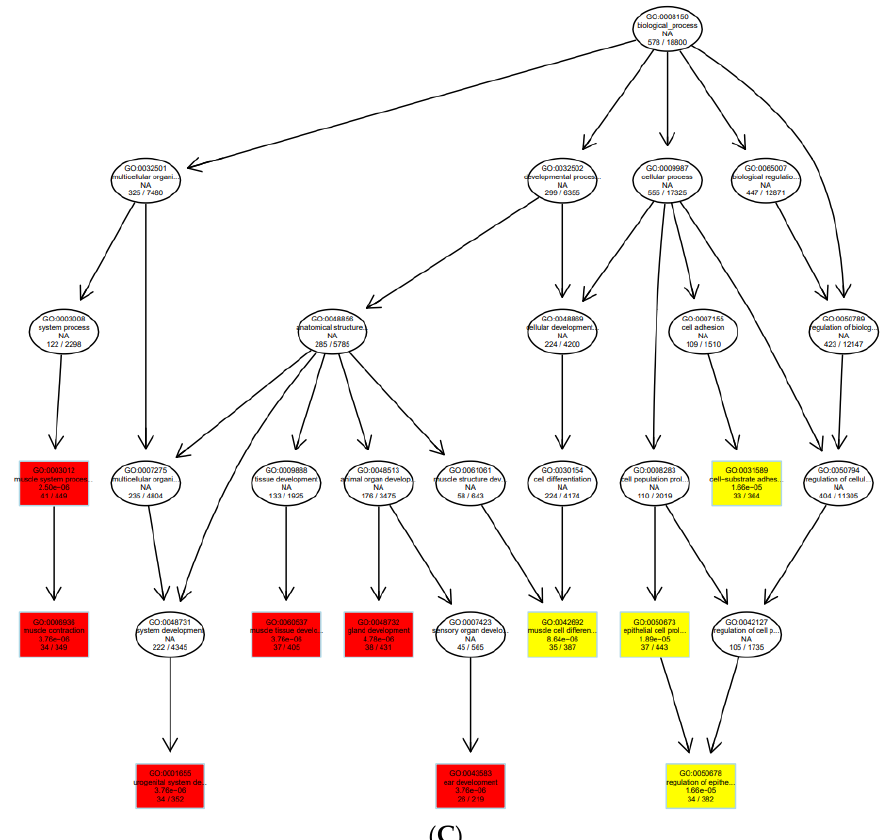
Figure 9. GO graph visualization of the top GO terms enriched. ( A ) A GO sub-graph has been created using the top 30 GO keywords in the category “Cellular Component”. ( B ) A GO sub-graph has been created using the top 30 GO keywords in the category “Molecular Function”. ( C ) A GO sub-graph has been created using the top 30 GO keywords in the category “Biological Process”. Boxes indicate the most significant terms. From dark red (most significant) to light yellow (least significant), the color of the box indicates the relative significance.